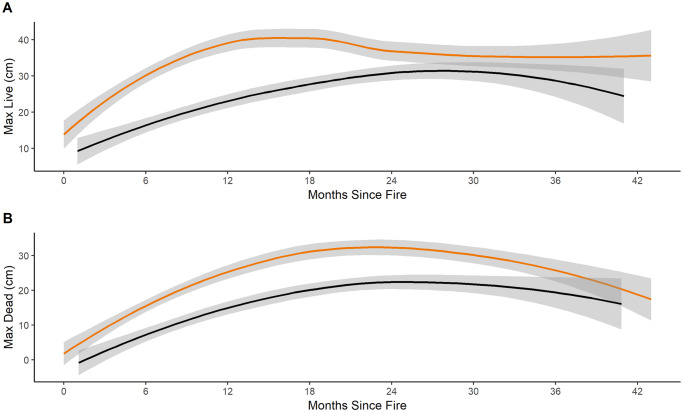
Maximum live and dead vegetaton.Maximum heights (cm) of live (A) and dead (B) vegetation in fire-only (orange) and pyric herbivory (black) treatments at all sites from 2014 to 2016. Shaded area indicates 95% confidence interval. *Regression lines and confidence intervals generated using “loess” locally-weighted smoothing function.